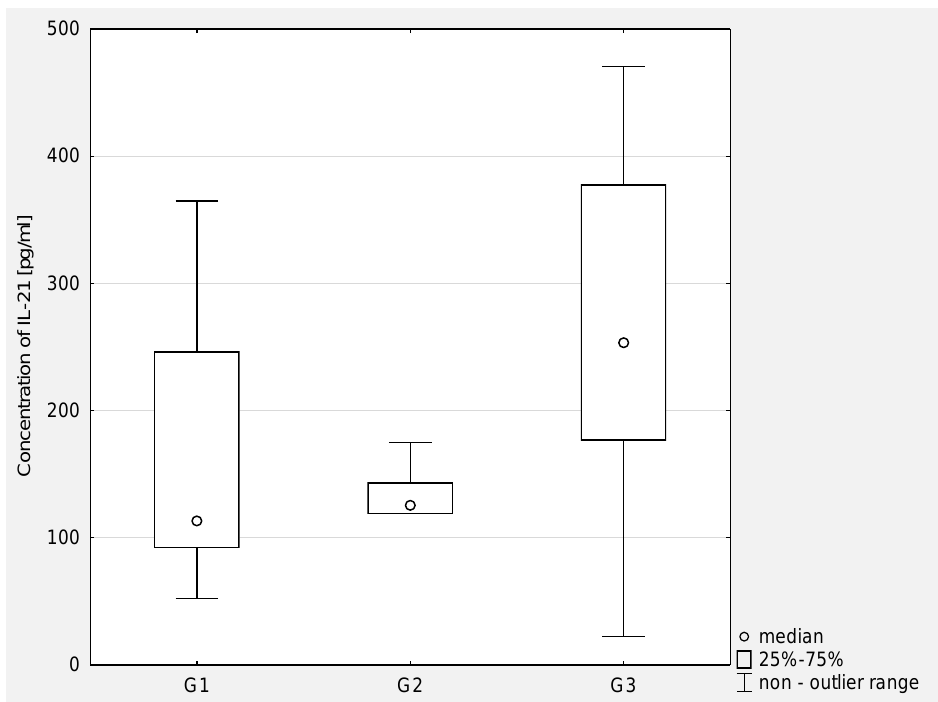
Figure 3. The concentration of IL-21 in the serum of women with ovarian cancer depending on the degree of differentiation G1 (well differentiated), G2 (moderately differentiated), G3 (poorly differ- entiated) compared to the control group.